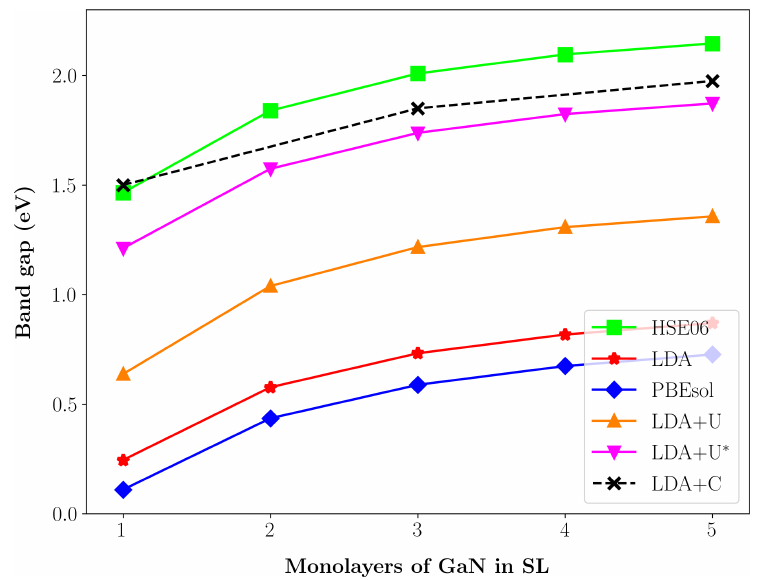
Figure 6. KS band gaps of the (1:1–5) superlattices computed using LDA, PBEsol, LDA+U with U-parameters taken from Carvalho et al. [14] and obtained in this work (U ∗ ). For the comparison, LDA+C values from [13] are also